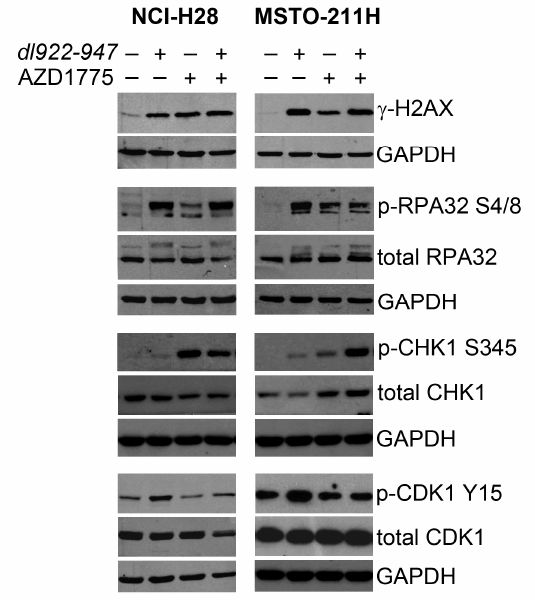
Figure 3. Effect of dl922-947 and AZD1775 on the activation of cyclin-dependent kinase 1 (CDK1) and DNA damage signaling factors in malignant mesothelioma (MM) cell lines. NCI-H28 and MSTO-211H cell lines were treated with dl922-947 and AZD1775, both alone and in combination, and analyzed through Western blotting for the following factors: phosphorylated histone H2AX ( γ -H2AX); phospho-replication protein A (RPA)32 Ser 4/Ser 8 and total RPA32; phospho-checkpoint kinase 1 (CHK1) Ser 345 and total CHK1; phospho-CDK1 Tyr 15 and total CDK1. DMSO was added to untreated control cells. An anti-GAPDH antibody was used for loading control.